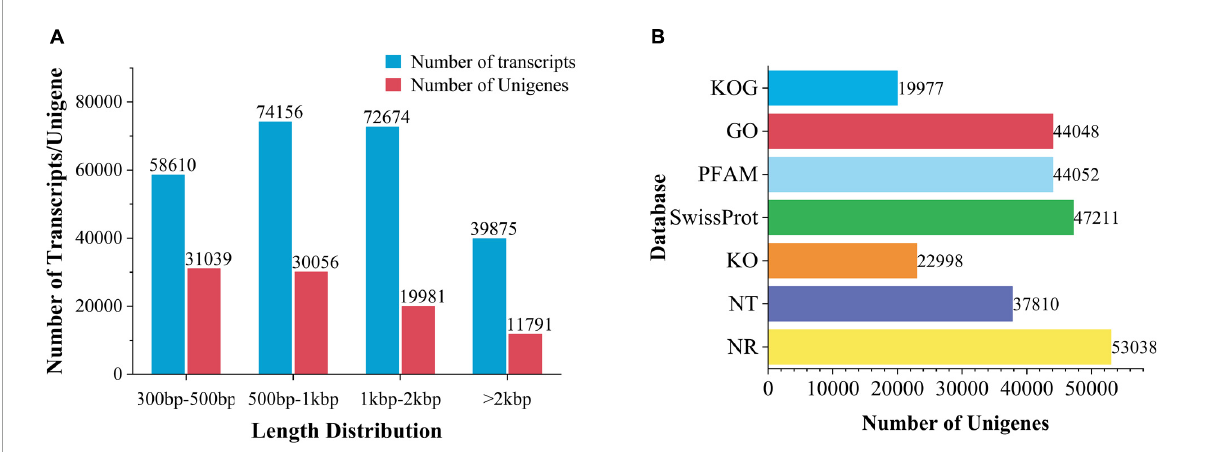
FIGURE3 Transcription splicing and database annotation. (A) Transcripts and Unigenes length distribution. (B) Number of gene annotations in the